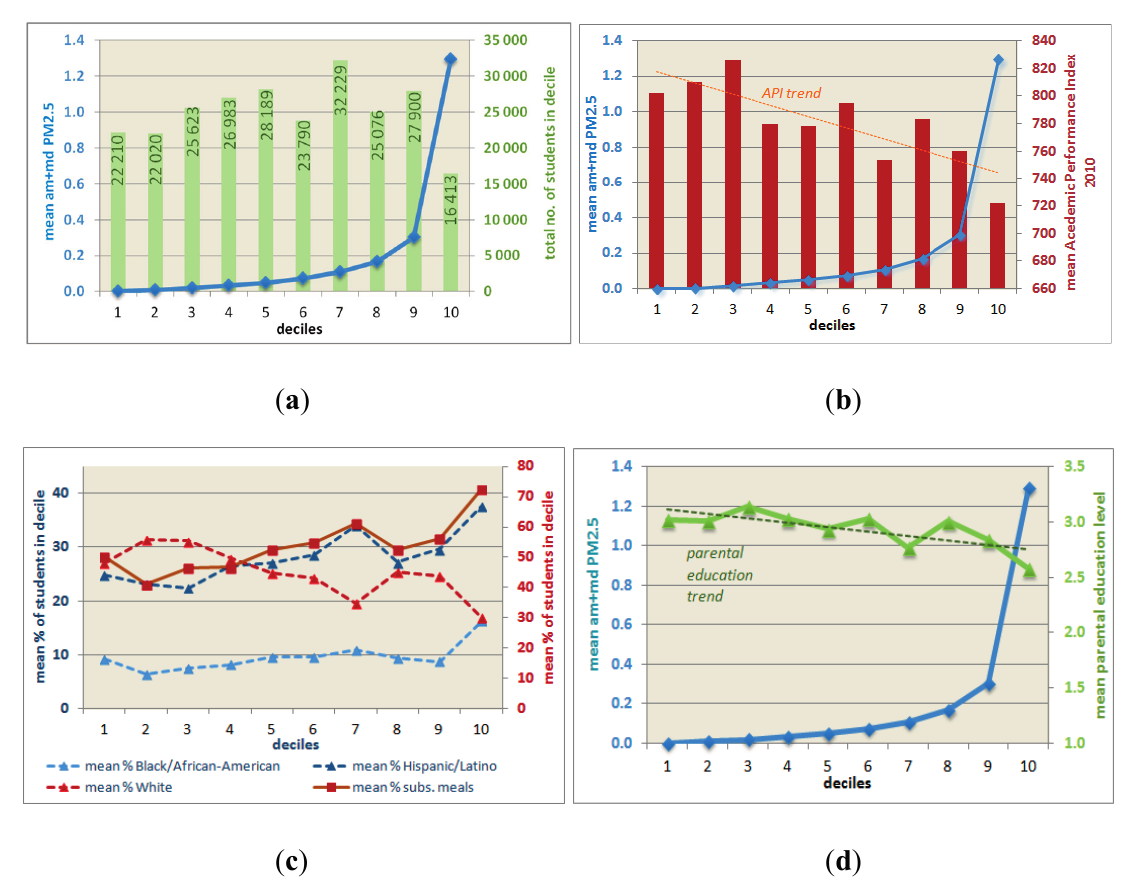
Figure 1. ( a-d ) Diagrams showing means of selected socio-economic variables within deciles of all schools’ am + md PM 2.5 emission loads (deciles along the x-axes, N =